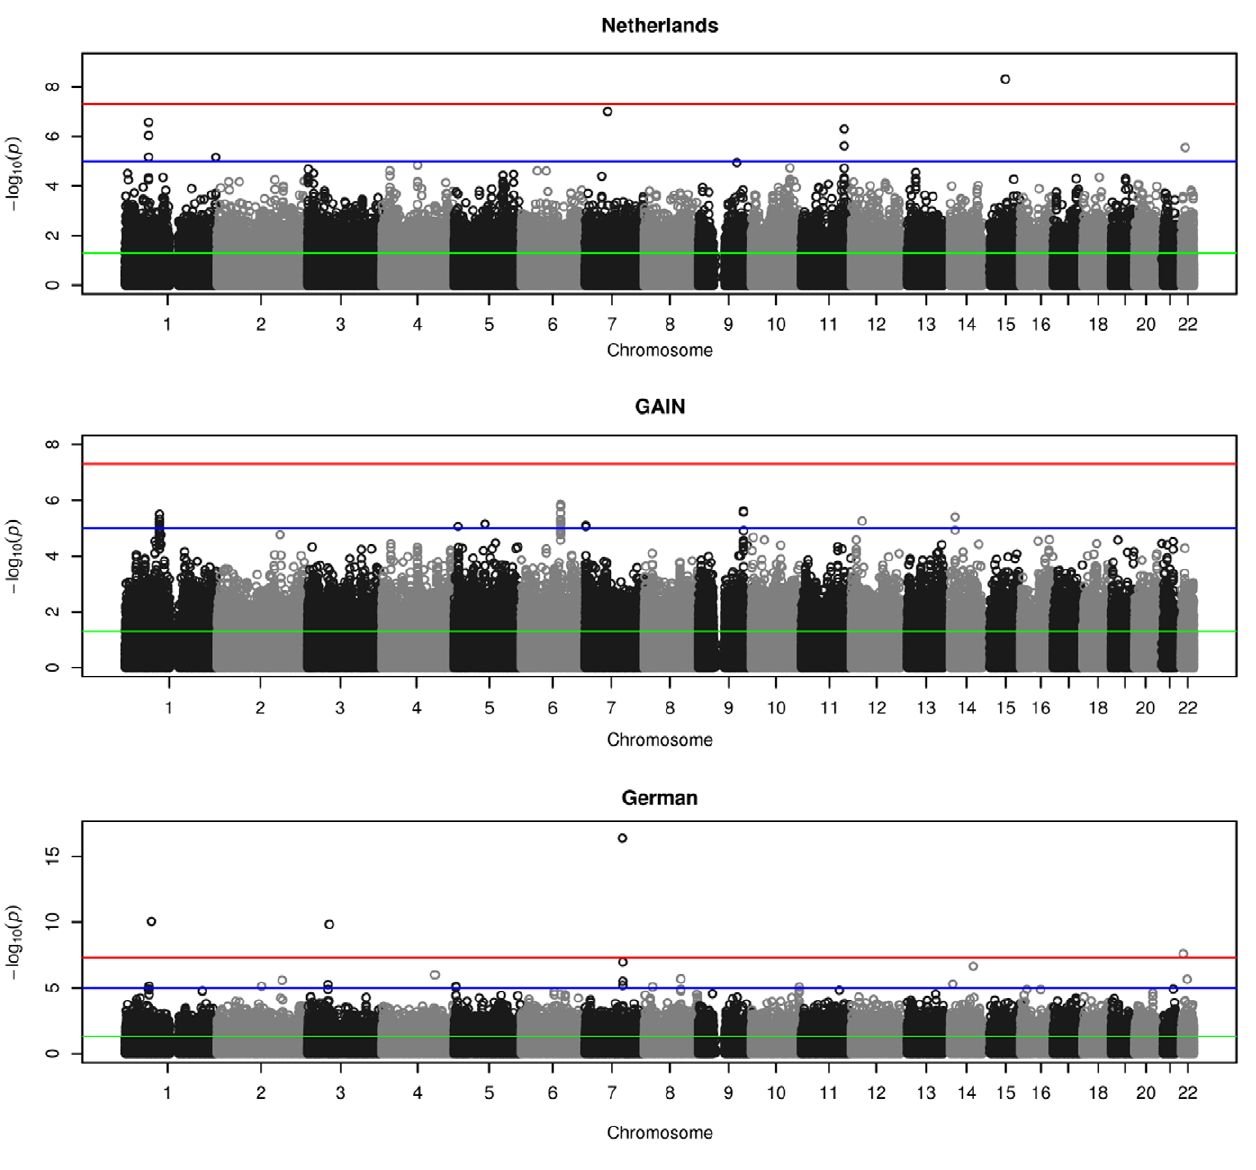
Figure 1. ‘‘Manhattan plot of the 22 autosomal chromosomes’’. This figure shows at the y–axis the p-values of the SNPs in a GWA analysis. The chromosomes are shown at the x-axis. The red line indicates a p-value of 10-7, the blue line indicates a p-value of 10-5 and the green line indicates a p-value of .05. doi:10.1371/journal.pone.0038828.g001 PLoS ONE |